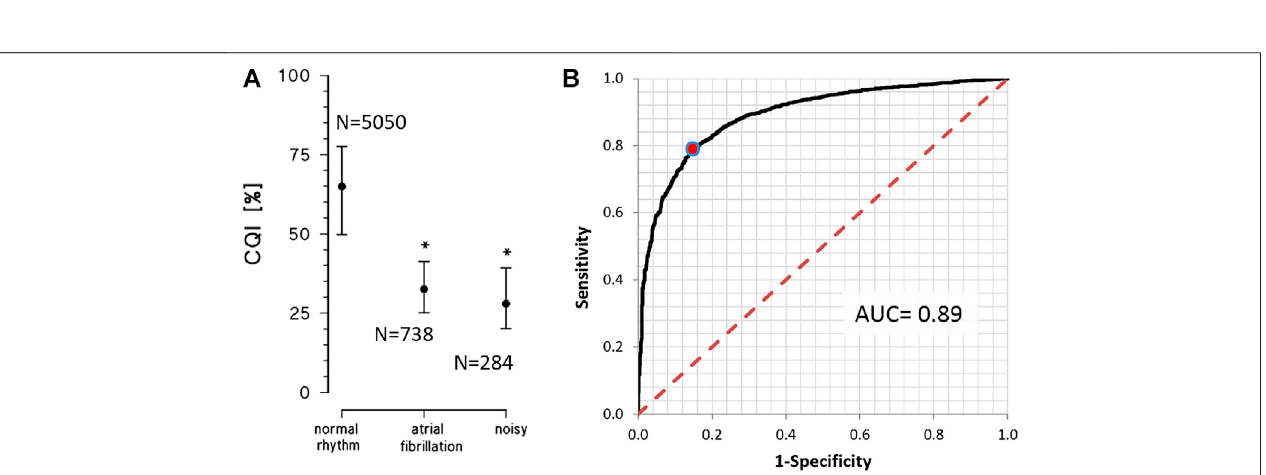
FIGURE7| Physionet/Computing inCardiology Challenge 2017datasets. (A) CQI asmedian and interquartile rangefor single-leadECGs manuallyclassi fi ed asin normal rhythm, atrial fi brillation or noisy recording. The * indicates a statistically signi fi cant difference vs. the normal rhythm group at p < 0.01 (B) ROC analysis on 5050 recordingsadequateforheartratevariabilityanalysis(normalrhythm)vs. 1022recordingsinadequateforheartratevariabilityanalysis(in atrial fi brillationornoisy);thered dot on the curve identi fi es the classi fi cation cut-off (CQI > 47%) according to the Youden ’ s criterion; AUC = Area Under the Curve.